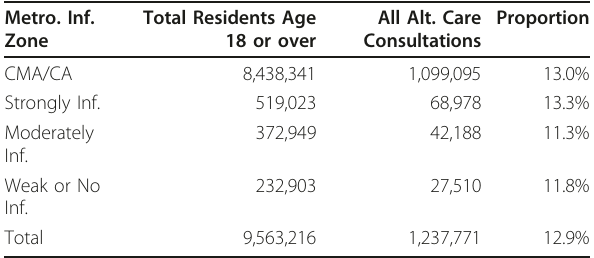
Table 4 Alternative Health Care Consultations Across the Urban to Rural Continuum in Ontario by Type, 2005 (Total and percent of all consultations in each MIZ) Metro. Inf.